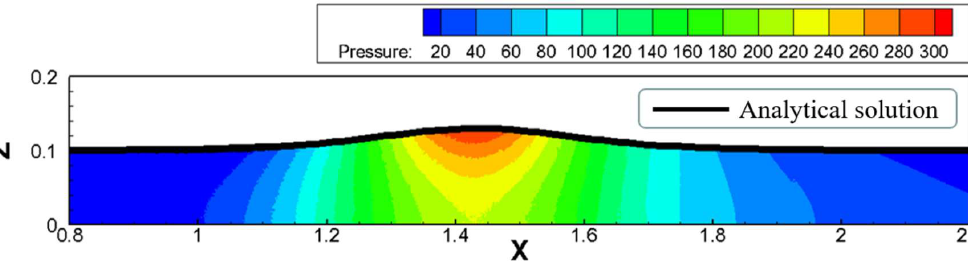
Figure 8. Simulated solitary wave profile compared with analytic solution and distribution of dynamic pressure for wave height ratio H / h = 0.3 (constant slope angle = 90°).